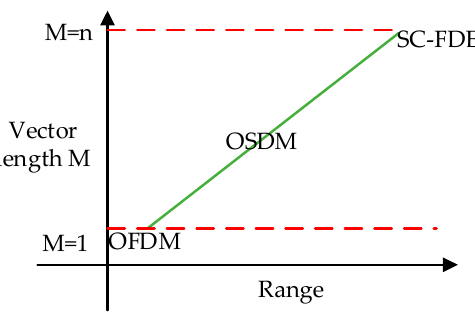
Figure 9. The relationship between the vector length and propagation range.